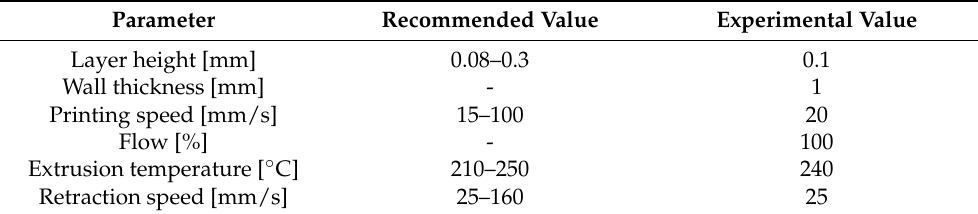
Table 2. Manufacturing process parameters defined for Filaflex ® 82A TPU filament.